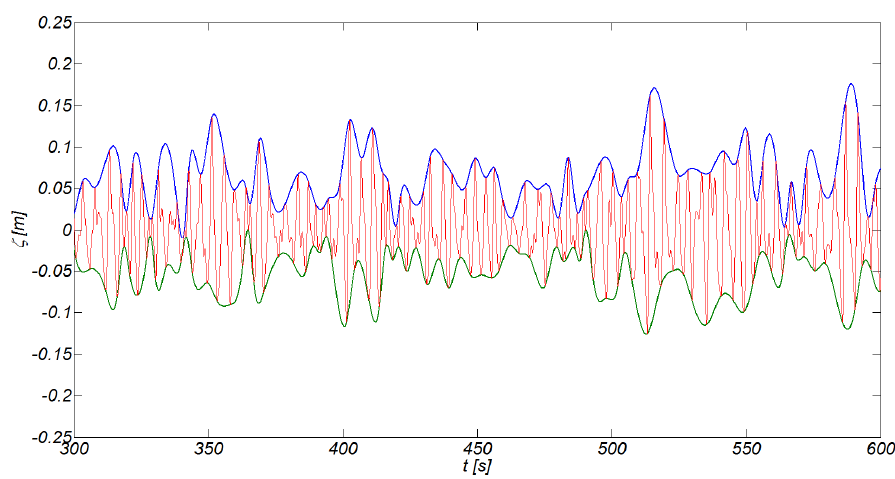
Figure 1. Time series of measured water surface displacement with its envelope process (thick solid line).